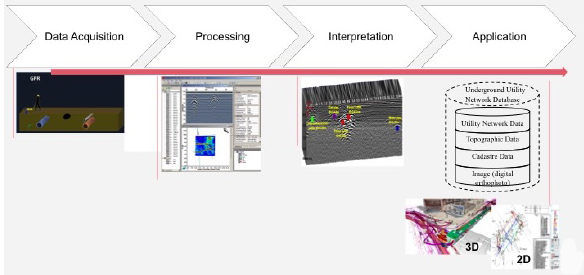
Figure 3. Workflow of underground utility